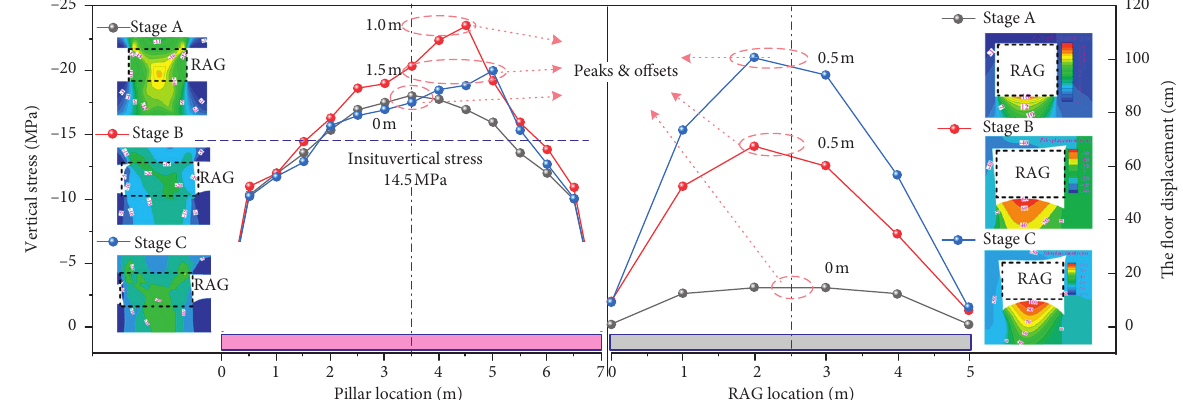
Figure 13: Simulated stress distribution and floor heave in the three stages.